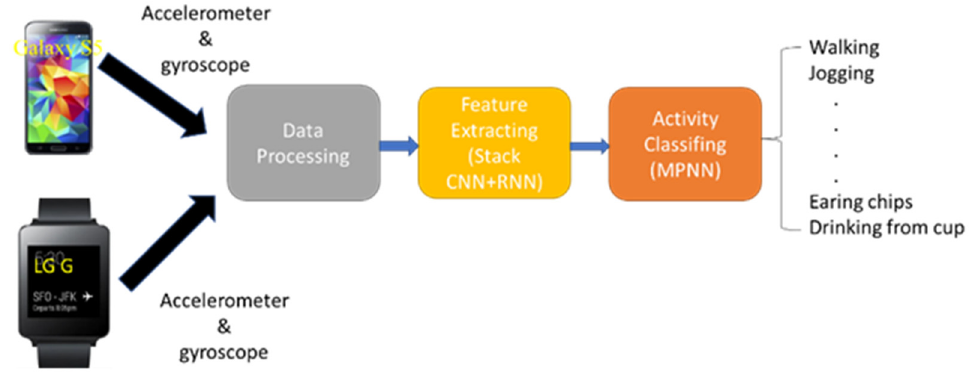
Figure 1. Structural diagram of the proposed HAR system, including the data processing unit, the feature extraction unit, and the classification unit.